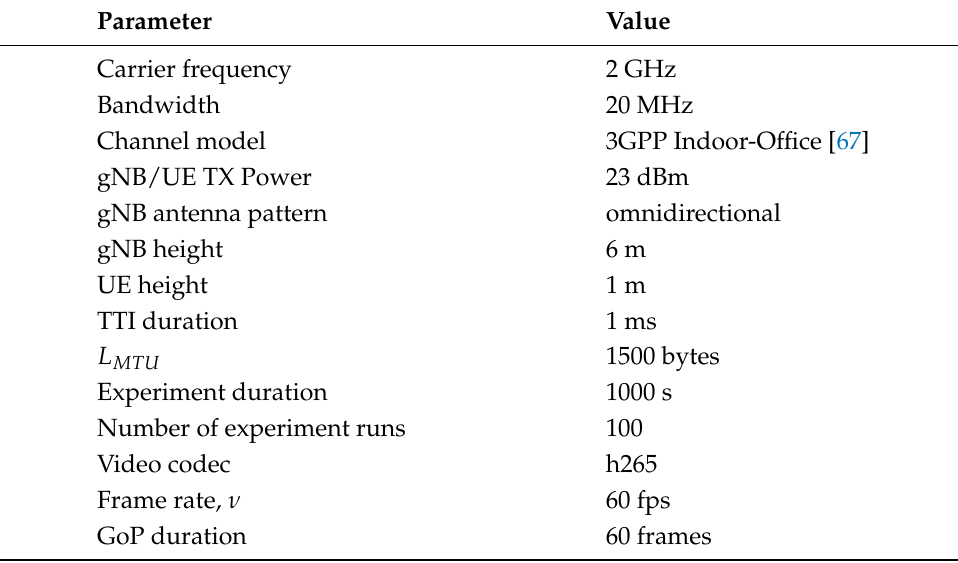
Table 1. Scenario